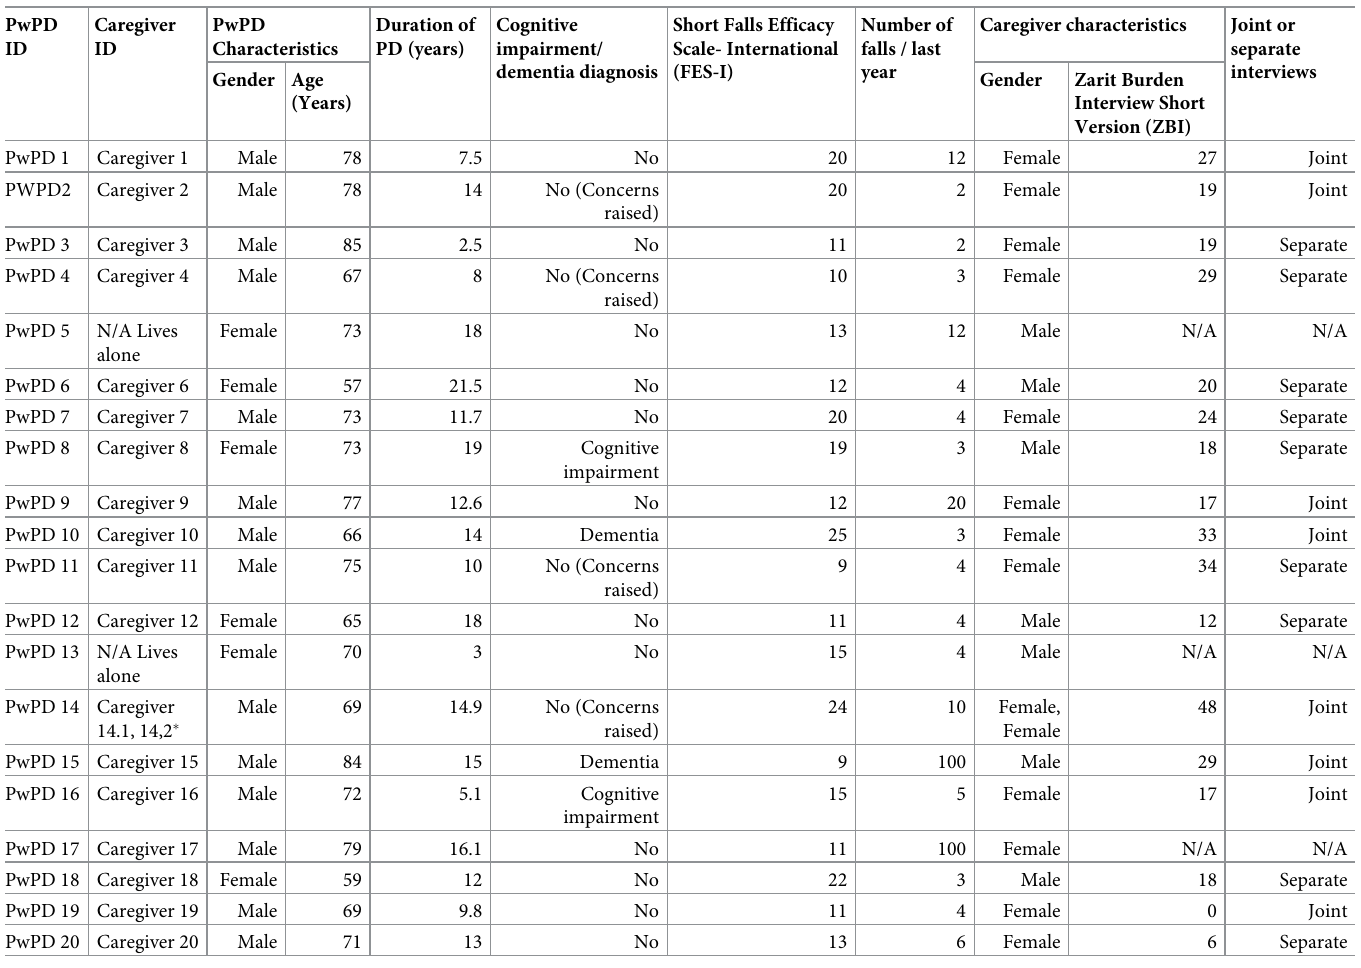
Table 2. Characteristics of people with Parkinson’s disease and their caregivers.